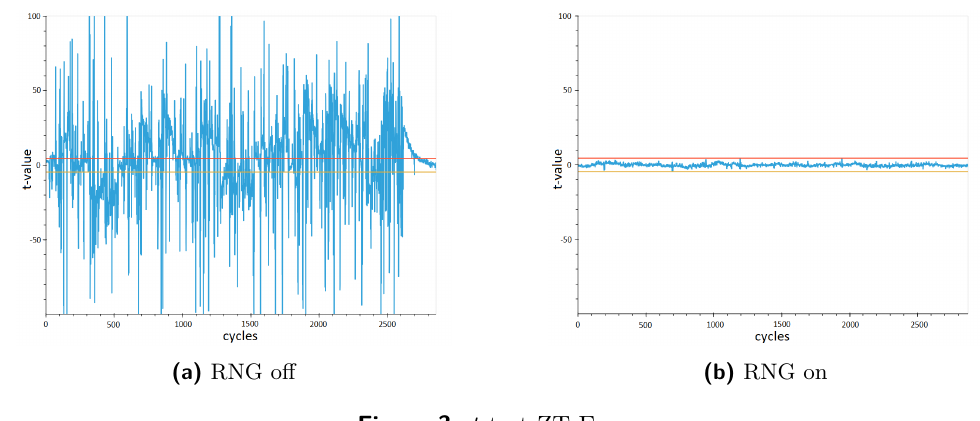
Figure 3: t -test